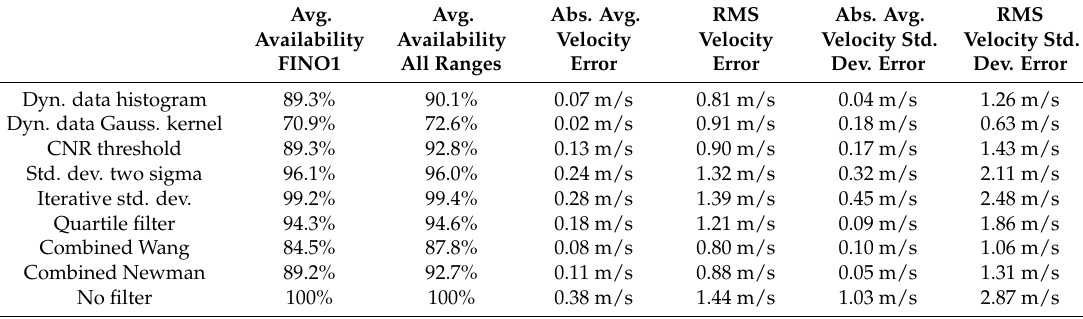
Table A2. Comparison of different filtering methods applied on staring mode measurements for free inflow condition and wind directions from 180 ◦ to 210 ◦